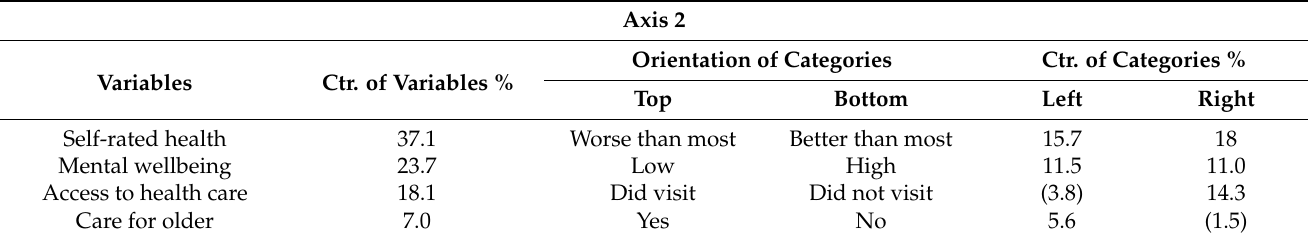
Table 3. Interpretation of Axis 2; 6 response categories contributing above-average to axis variance, 2 additional categories contributing below-average added in brackets. Ctr. of variables and categories are in